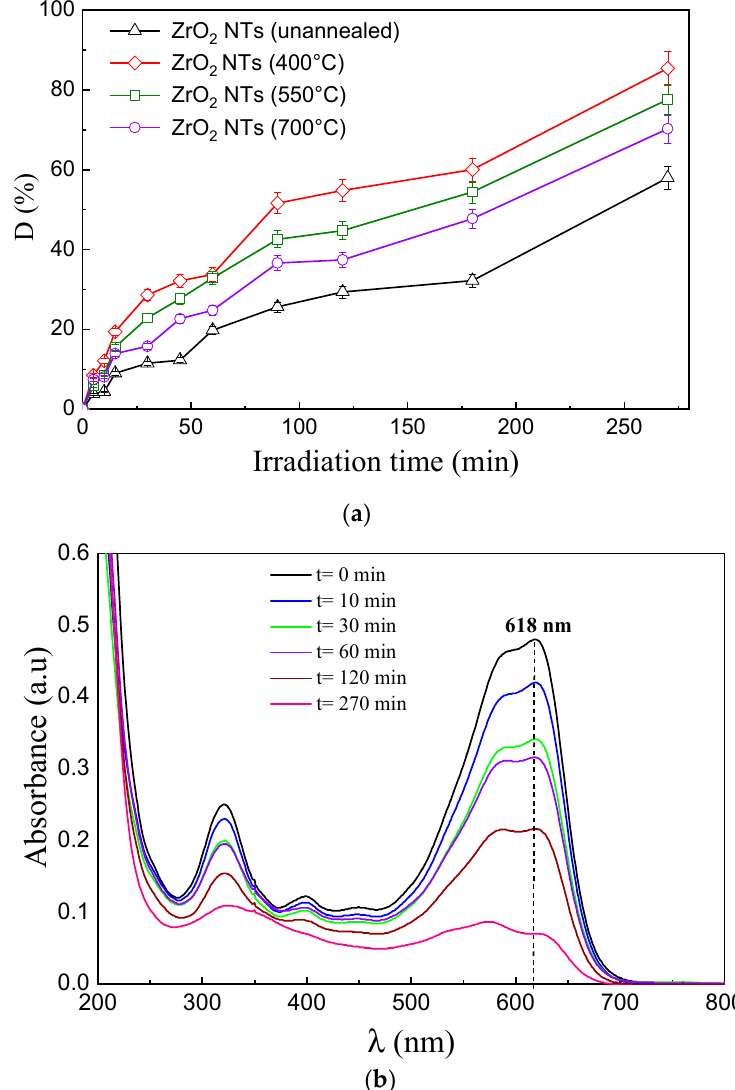
Figure 10. ( a ) The photocatalytic degradation of BA in the presence of unannealed and annealed ZrO 2 NTs (400, 550, and 700 °C) versus irradiation time. ( b ) Absorbance spectra illustrating Black Amido photo-degradation during UV light irradiation in the presence of ZrO 2 NTs (annealed at 400 °C).